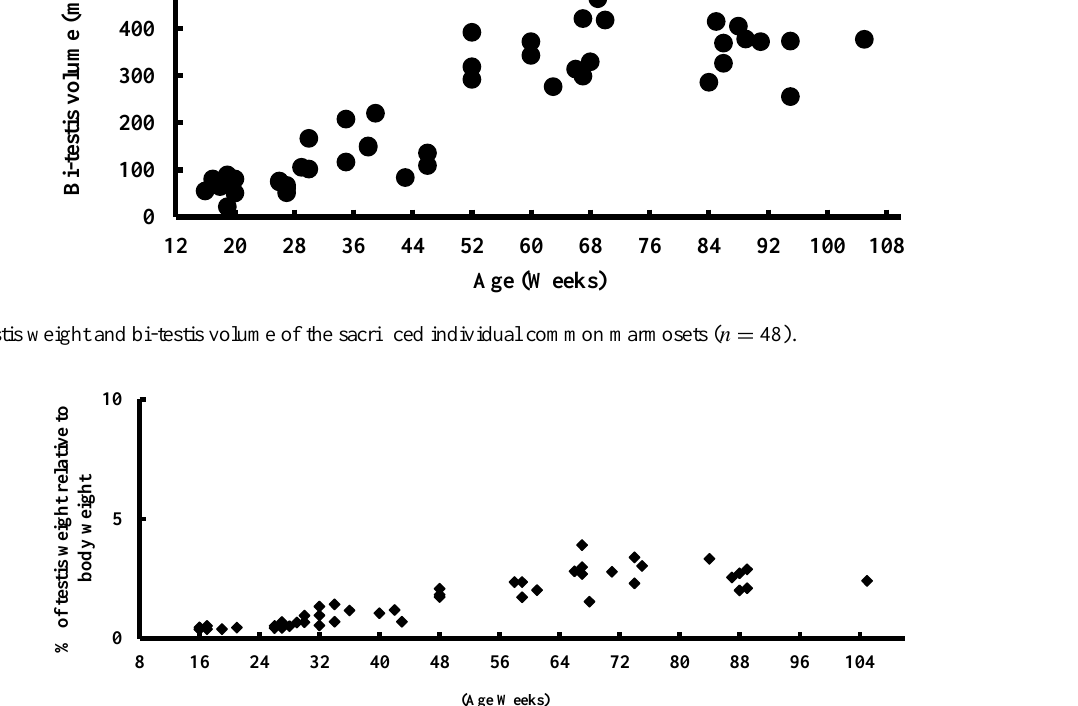
moset. The maximum body weight gain had been observed well within the first 6 months of age before the pubertal ac- tivation. After 6 months the animals showed a slower rise in the body weight. Whether the initial weight gain is a pre- requisite for the pubertal activation remains to be